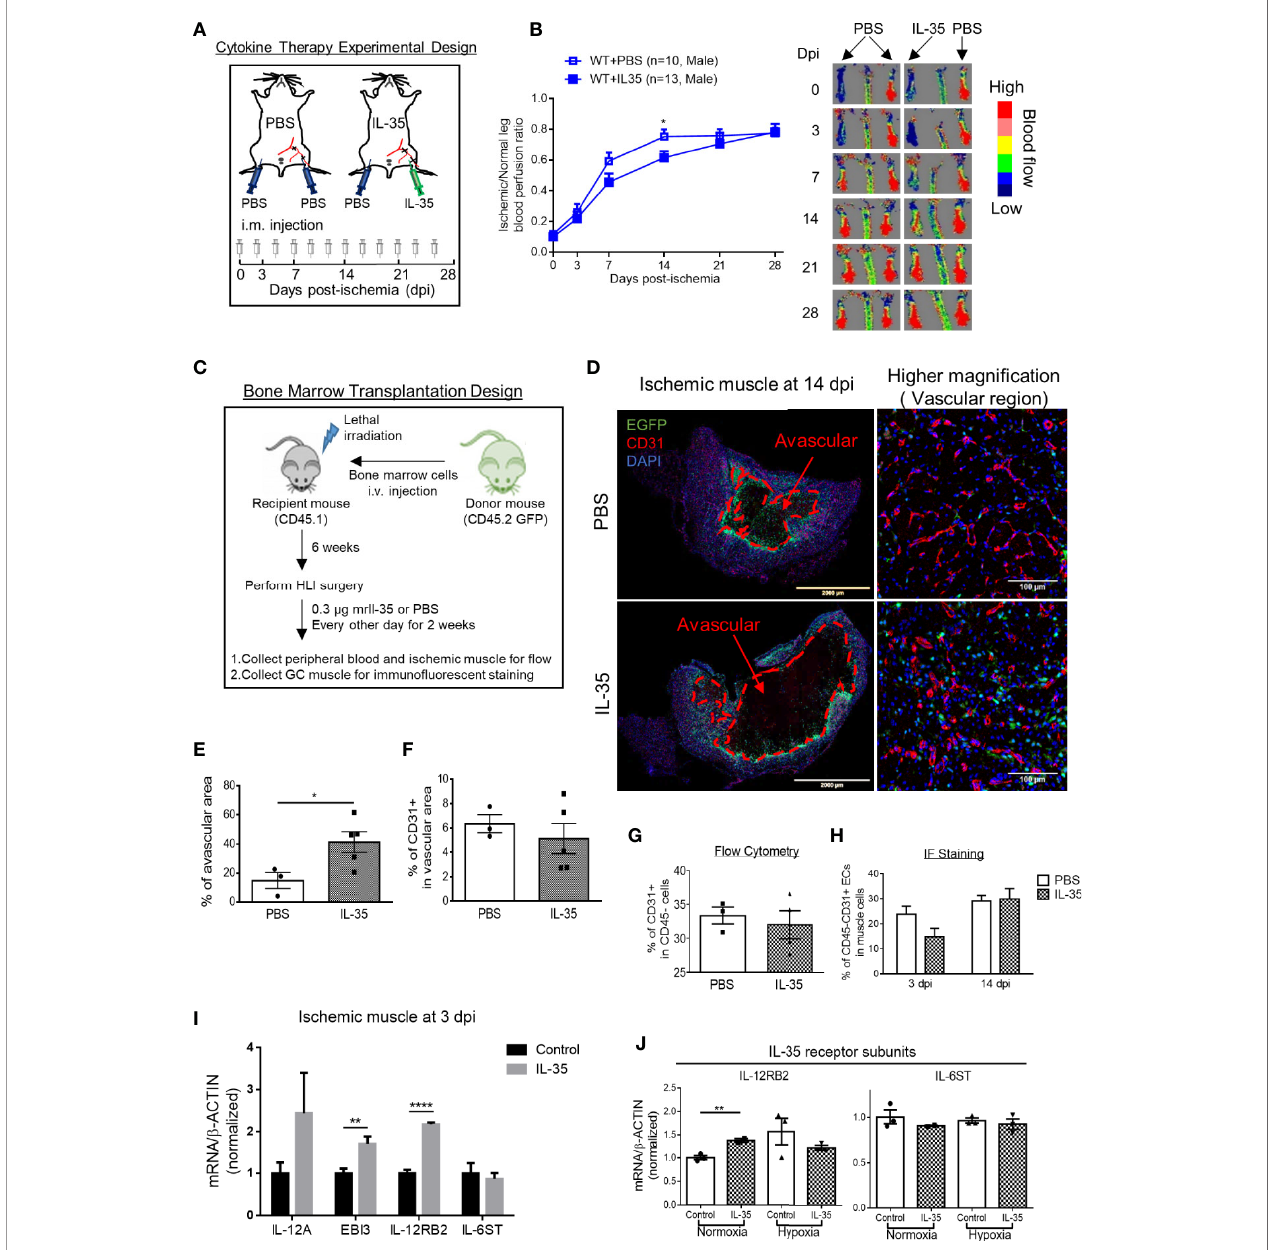
FIGURE 3 | IL-35 cytokine injection delays blood perfusion recovery in the ischemic leg of hindlimb ischemia (HLI) and increases gene expression of IL-12RB2. (A) Experimental schematics. IL-35 group mice were intramuscularly (i.m.) administered with IL-35 [0.3 µg/gastrocnemius (GC) muscle in 20 µl PBS] at the time of HLI procedure and three times a week afterwards until the end of observation. The non-surgical limb was also injected with 20 µl PBS as internal control. (B) Blood perfusion ratio of IL-35- or PBS-injected WT or Il12rb2 − / − mice. (C) Bone marrow transplantation experimental schematics. (D) Representative images of the whole GC muscle (left panel) and higher magni fi cation of vascular density (right panel) in vascular area of PBS- or IL-35-injected ischemic muscle at 14 dpi. Tissues were stained with anti-CD31 (red) and DAPI. Lines, where blood vessels were rarely visible. The left two images were taken using tile scan in Leica TCS SP8 system and merged to present the whole tissue section. The avascular area was indicated with red dash at 14 dpi. (E) Statistics of the percentage of the avascular area EGFP+ indicated in fi ltrated bone marrow-derived cells. (F) Statistics of the percentage of CD31+ cells in the vascular area of the GC muscle at 14 dpi. (G) Statistics of percentage of CD31+ cells in CD45 − cell population in IL-35 or PBS-injected groups using fl ow cytometry. (H) Percentage of CD45+CD31+ ECs in IL-35 or PBS injected ischemic muscle at 3 and 14 dpi using immuno fl uorescent staining. (I) Normalized gene expression of IL-35 signaling complex in the ischemic muscle at 3 dpi. IL-35 group mice were i.m. injected with IL-35 at the time of HLI surgery. (J) Normalized mRNA expression levels of IL-35 receptor subunits after 6 h of 40 ng/ ml of IL-35 treatment in HMVECs under normoxia or hypoxia condition. All animal results were collected from male mice. Data are presented as mean ± SEM. *p < 0.05; **p < 0.01; ****p <